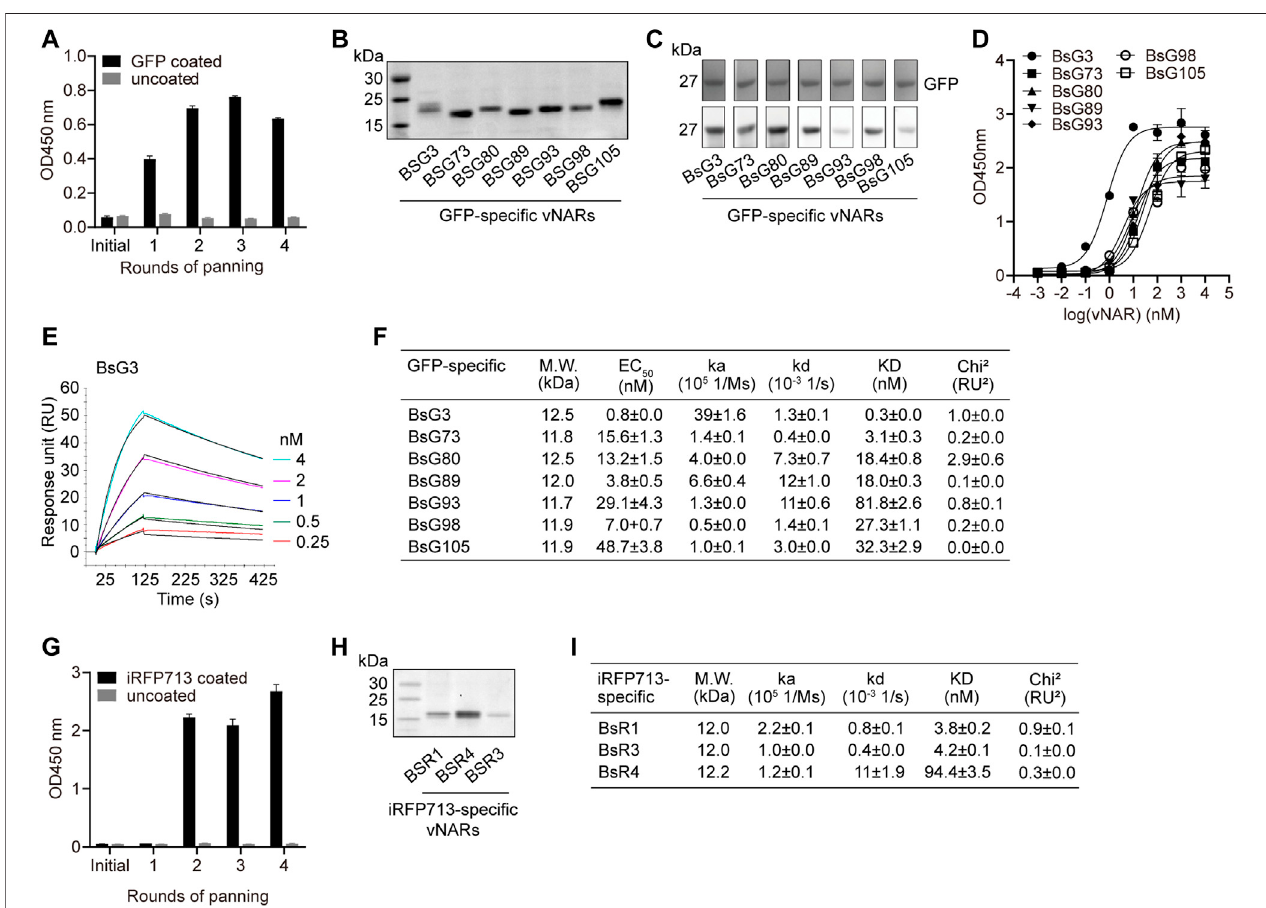
FIGURE5| Identi fi cationofhigh-af fi nityGFP-speci fi candiRFP713-speci fi cvNARsfromimmunizedlibrary. (A) EnrichmentofGFP-speci fi cvNARsduringpanning. (B) SDS-PAGE of seven puri fi ed anti-GFP vNARs. (C) Functional validation of vNARs. (D) EC 50 of vNARs against GFP. (E) SPR sensorgram of BsG3 binding with GFP. (F) Bindingaf fi nitiesandEC 50 ofsevenvNARsagainstGFP.Thevaluesrepresentmean ± standarderror. (G) EnrichmentofiRFP713-speci fi cvNARsduringpanning. (H) SDS-PAGE of three puri fi ed anti-iRFP713 vNARs. (I) Binding af fi nities of three vNARs against iRFP713. The values represent mean ± standard error.